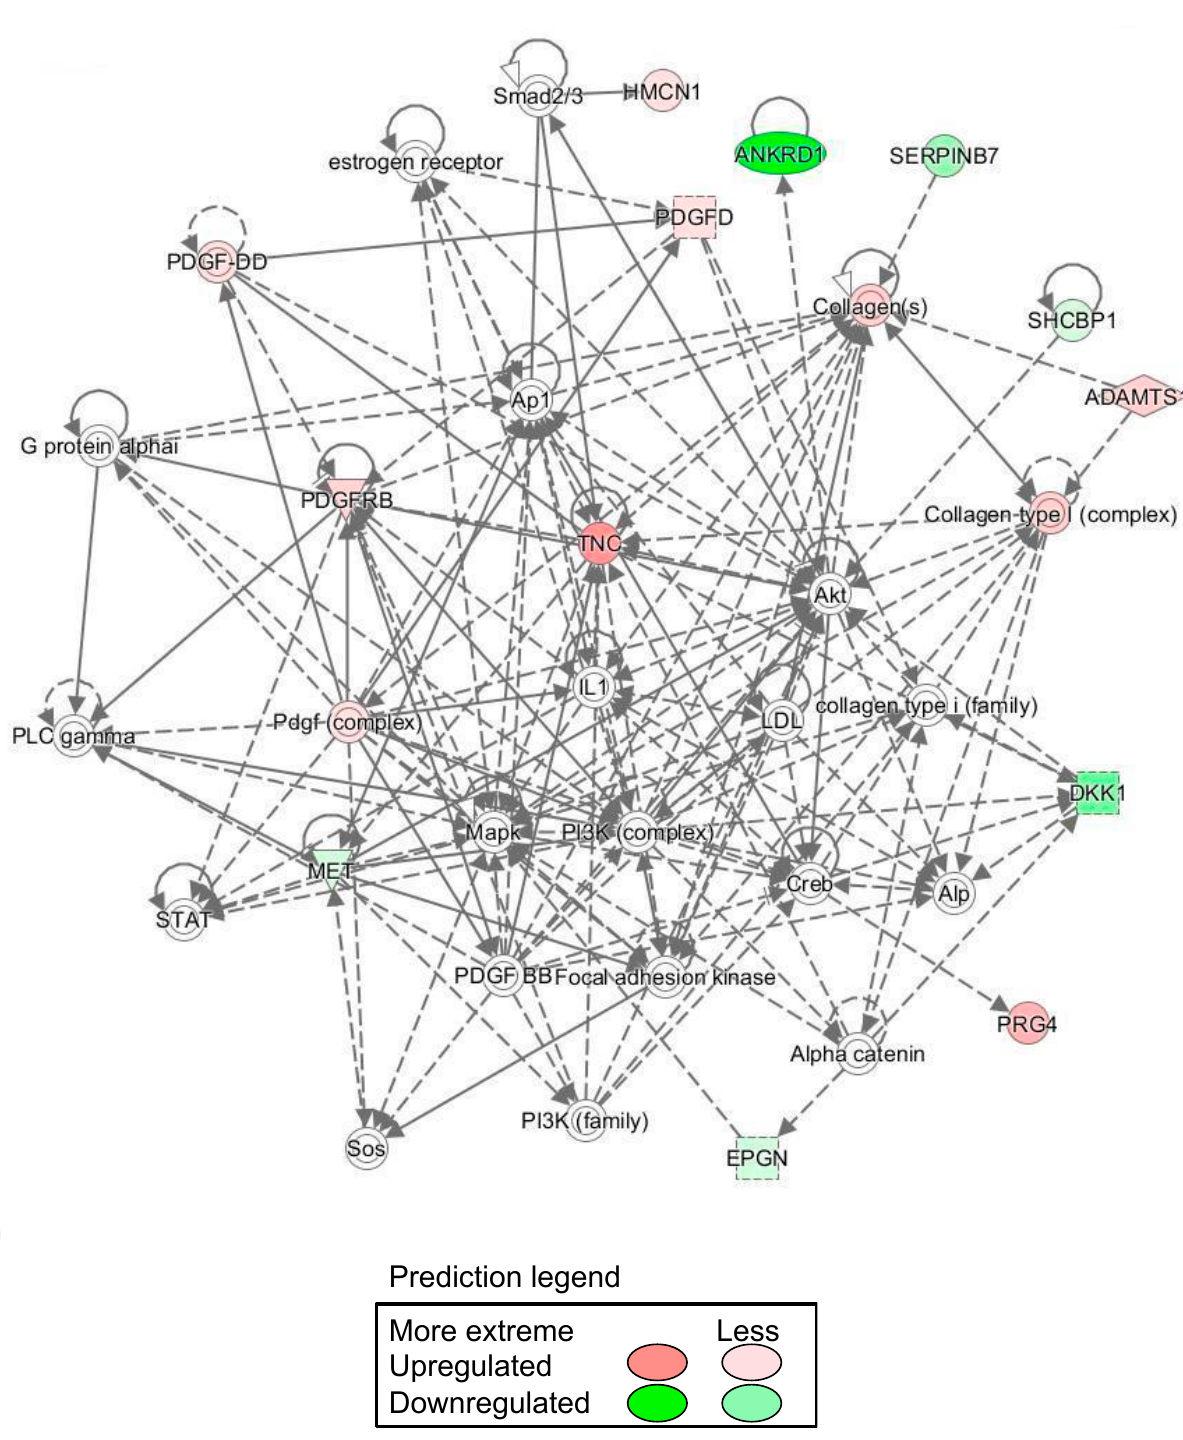
Figure 6. Ingenuity pathway analysis-identified spheroid gene network. IPA also predicted the gene network included Akt, MAPK and